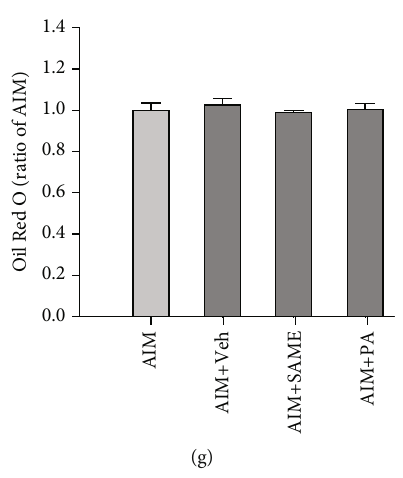
Figure 1: PAME increases adipogenic di ff erentiation in rAD-MSCs. Treatment with PAME (10-100 μ M) in adipogenic induction medium for 12 days enhanced rAD-MSC adipogenic di ff erentiation evidenced by Oil Red O staining (a) and quantitation of lipid droplets (b). Values shown in parentheses represent the number in each group. PAME (50 μ M) signi fi cantly increased the mRNA levels of Ppar γ (c) ( n = 10 ) and Gpd1 (d) ( n = 11 ) and the protein level of PPAR γ (e) ( n = 5 ). (f) The e ff ect of PAME on adipogenic di ff erentiation was blocked by 0.5% BSA ( n = 5 ). (g) Veh (0.1% methanol), SAME (50 μ M), and PA (50 μ M) did not enhance adipogenic di ff erentiation of rAD-MSCs ( n = 10 ). All data represent mean ± SEM . ∗ p < 0 : 05 , versus the CM group; # p < 0 : 05 , versus the AIM group; $ p < 0 : 05 , versus the AIM+PAME group.